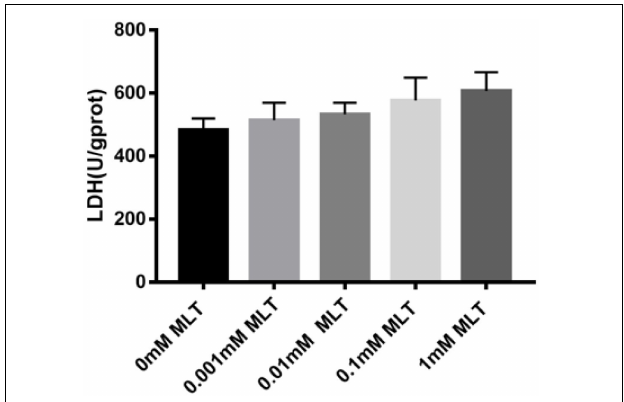
FIGURE 6 | Lactate dehydrogenase (LDH) assay. MLT in the vitrification medium at the indicated concentrations is not cytotoxic. Data are shown as the mean ± SEM.